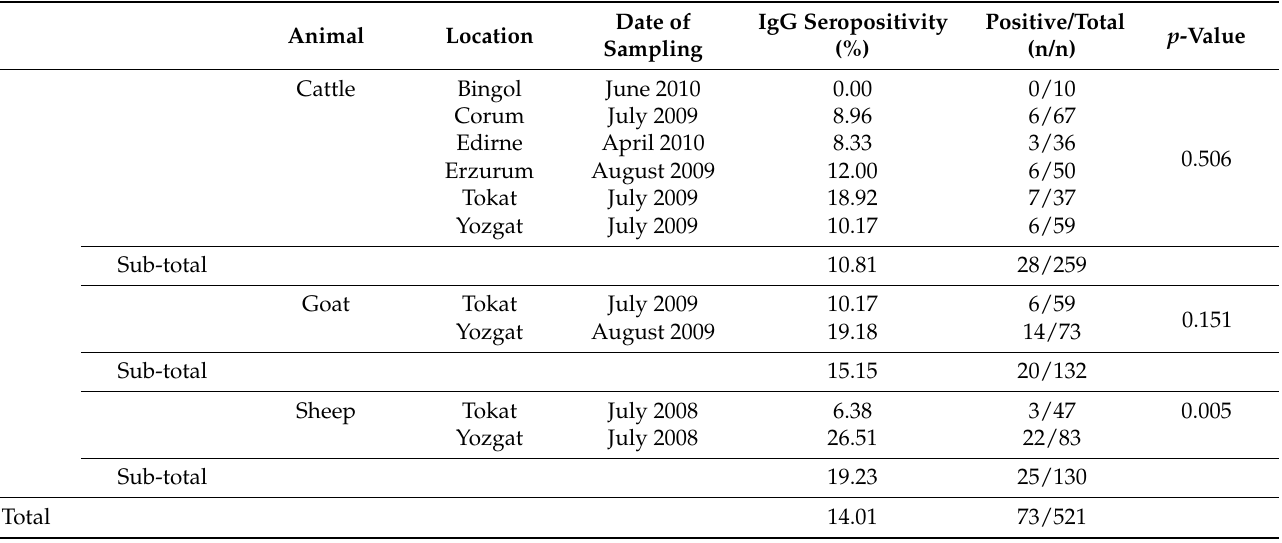
Table 1. Numbers and IgG iELISA seropositivity of CCHFV in domestic animals collected from various locations of Turkiye.